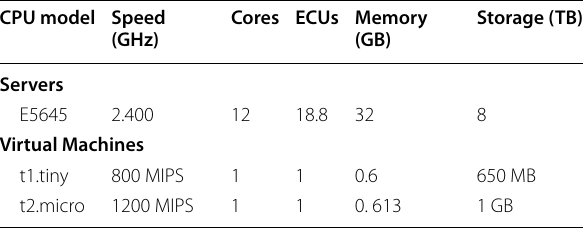
Table 8 Characteristics of machines used for simulated edge- cloud setup